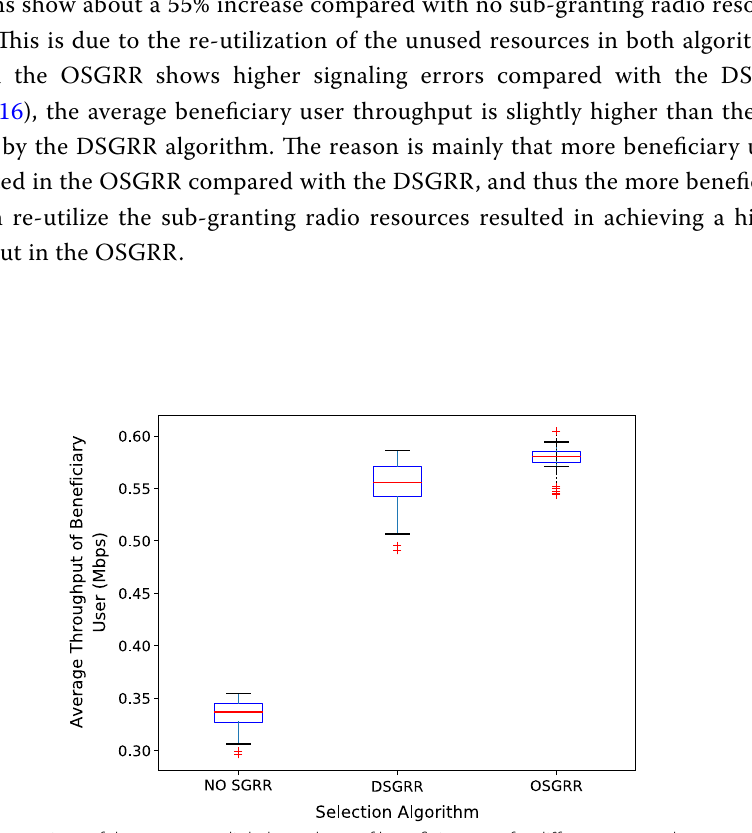
Fig. 18 Comparison of the average uplink throughput of beneficiary user for different